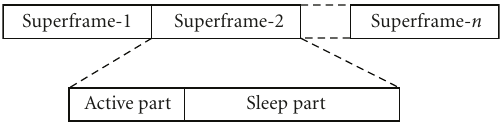
Figure 2: Active/sleep mechanism.